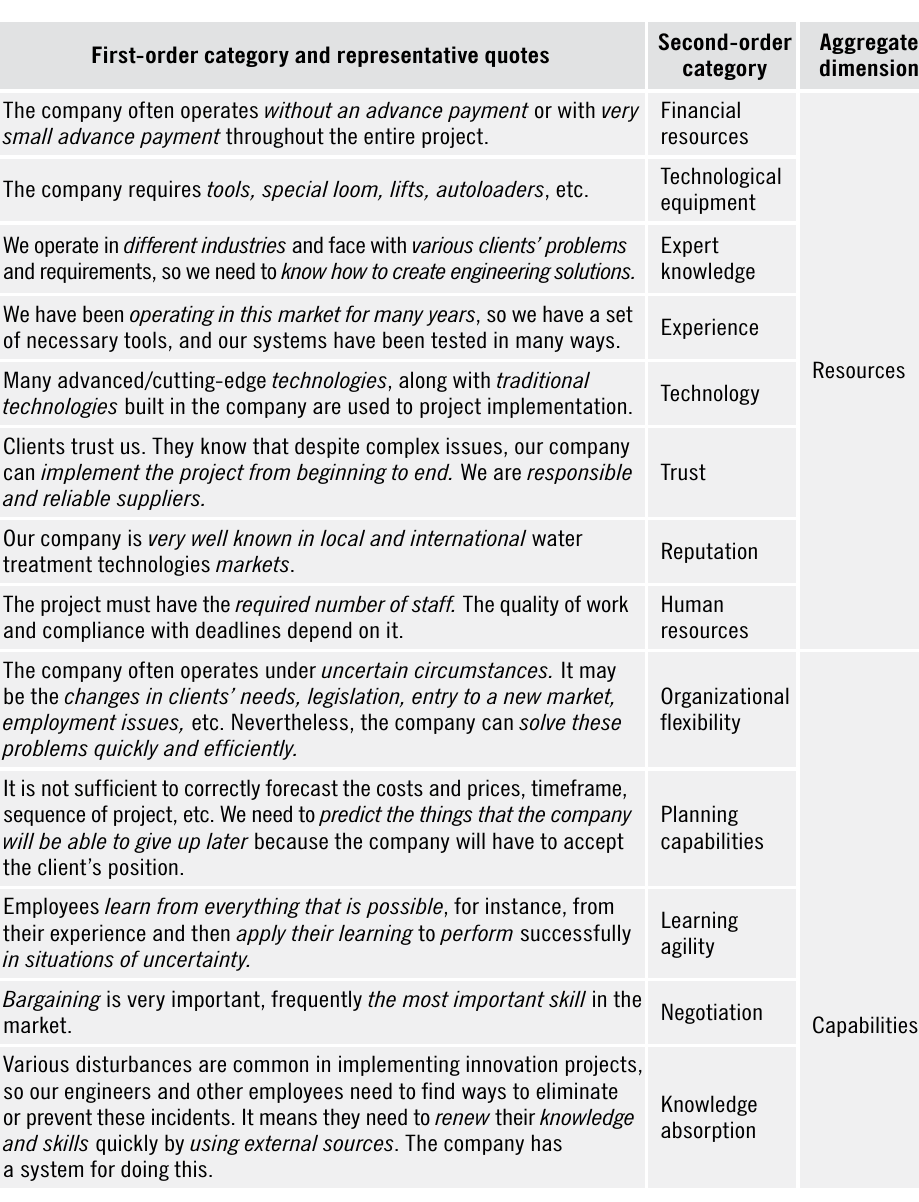
Table 5. Company resources and